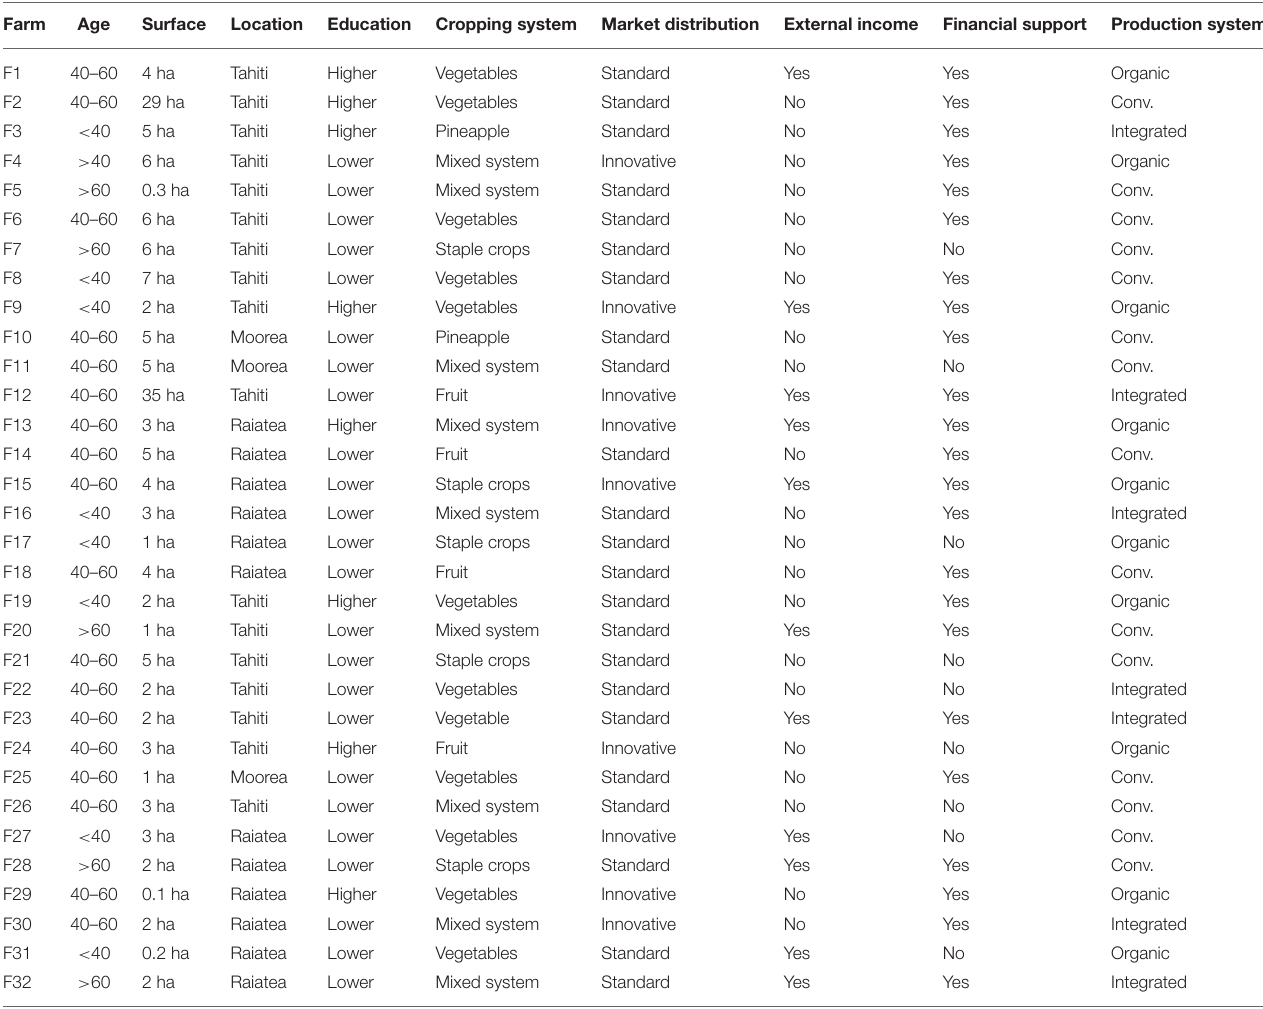
TABLE 3 | Characteristics of the 32 farms analyzed in French Polynesia.